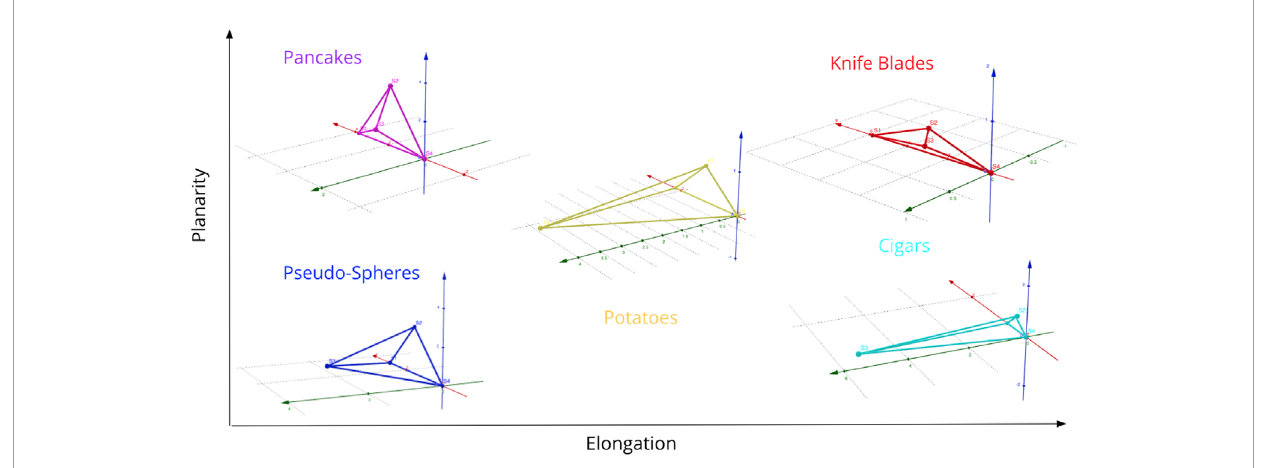
FIGURE 2 Exploring the efficiency of the curl-meter technique using five different types of tetrahedra as a function of elongation and planarity. According to Ayora Mexia. (2022), the pseudo-sphere is the best constellation formation to obtain the internal current density distribution within a FR.